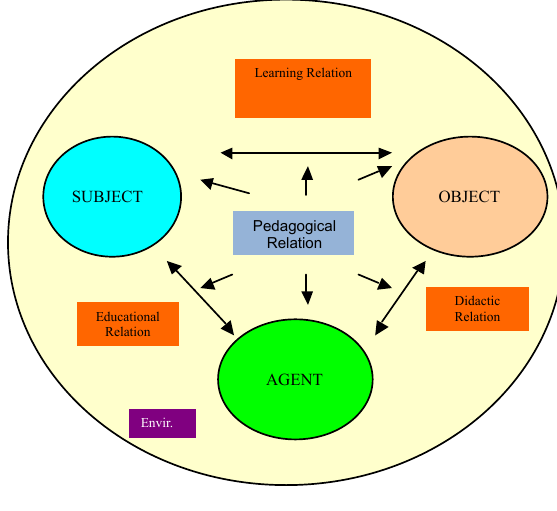
5 | Fig. 5: The Pedagogical Relationship Model (RP).